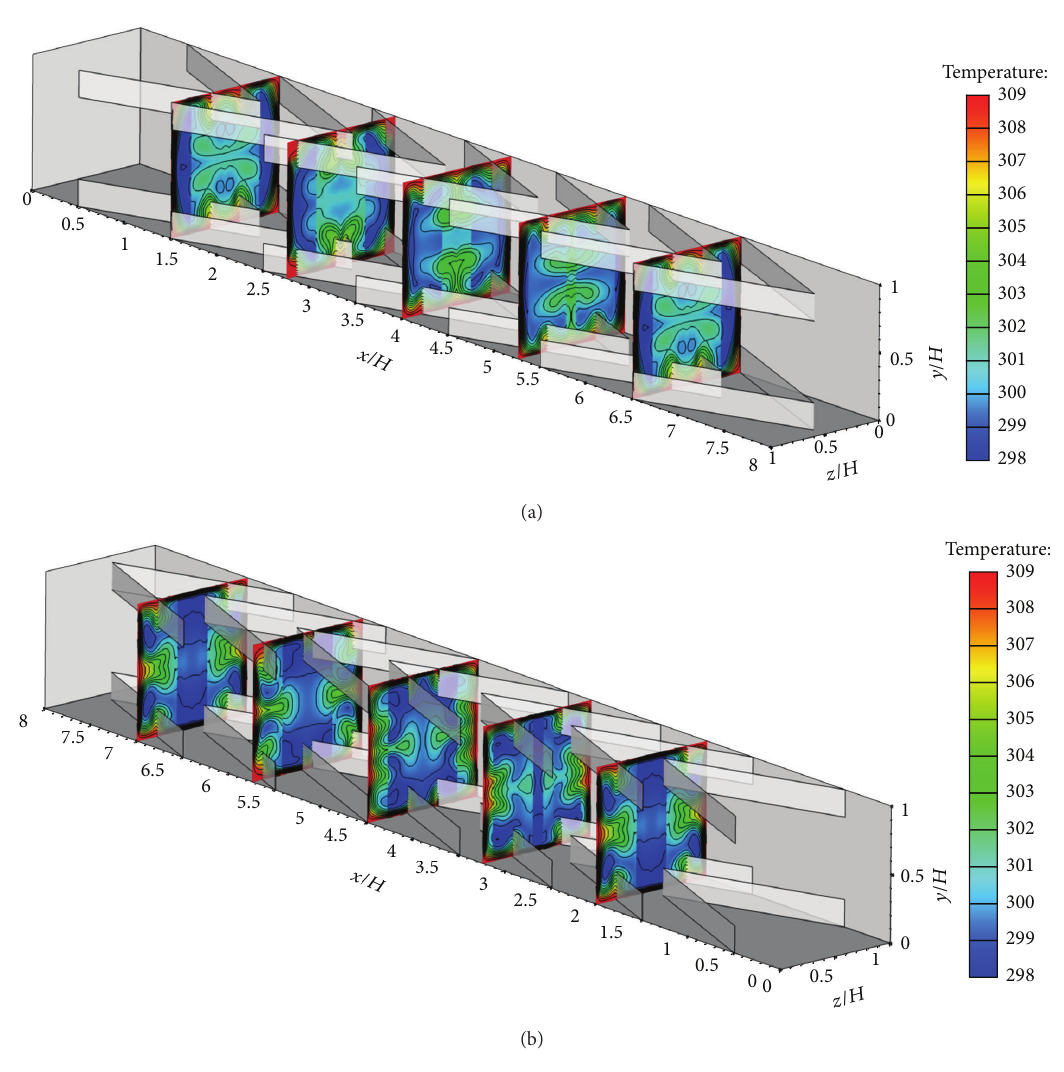
Figure 6: Contour plot of temperature in transverse plane for (a) V-Downstream and (b) V-Upstream of 20 ∘ V-rib at Re = 800 , BR = 0.20 , and PR = 1 .